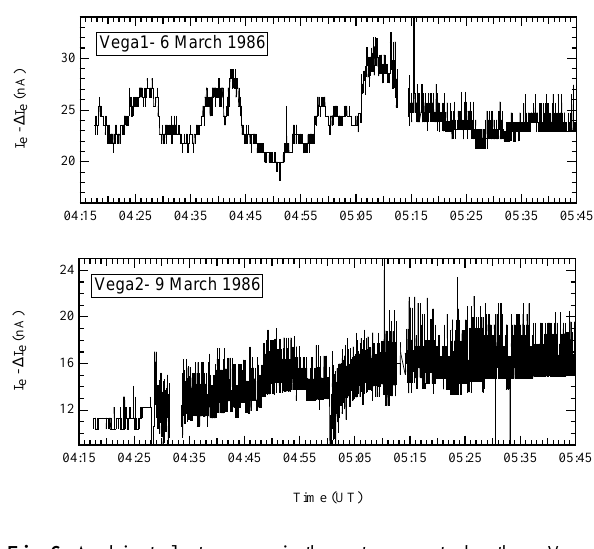
Fig. 6. Ambient electron flux in the outer cometosheath on Vega 1 (top) and Vega 2 (bottom) after correction for the gas release